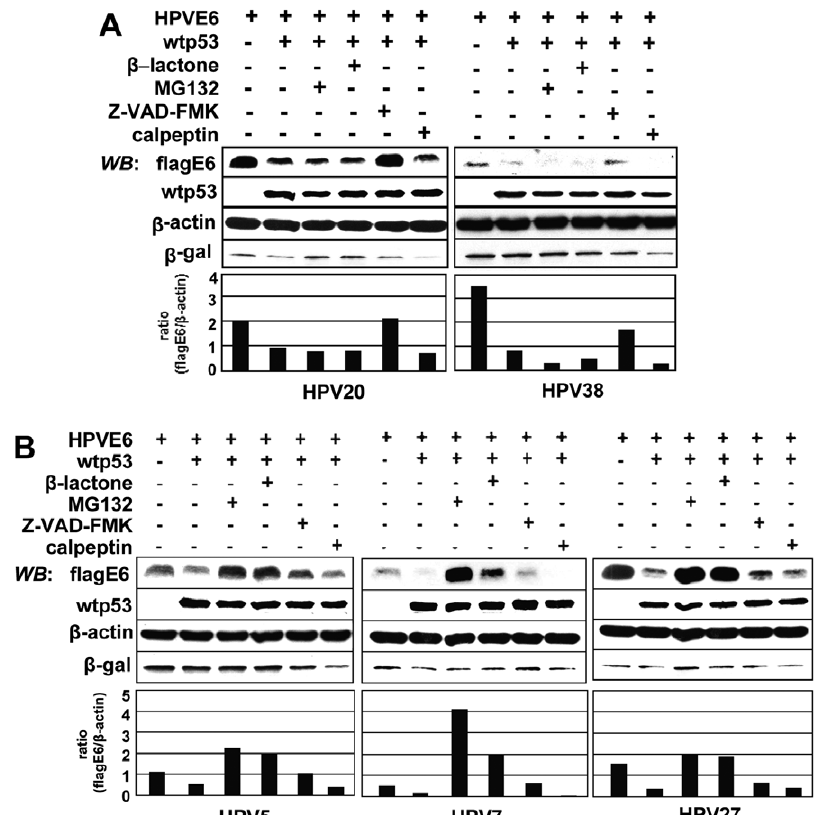
Figure 2. Degradation of the respective HPVE6 proteins. Wtp53 was co-expressed in H1299 cells with (A) HPV20E6 or HPV38E6, and (B) HPV5E6, HPV7E6 or HPV27E6. Transfected cells were treated with general caspase inhibitor Z-VAD-FMK (50 m M), calpeptin (calpain inhibitor, 25 m M) or proteasome inhibitors MG132 (20 m M) or b -lactone (Lactacystin 5 m M) prior to harvesting. Proteins were analysed by Western blot analyses and protein levels quantified by Imagequant. Histograms represent HPVE6 protein expression normalized against b -actin. Empty vector pcDNA3.1( + ) was co-transfected to equalize total amount of transfected DNA and transfection efficiency was controlled for by b -galactosidase expression.